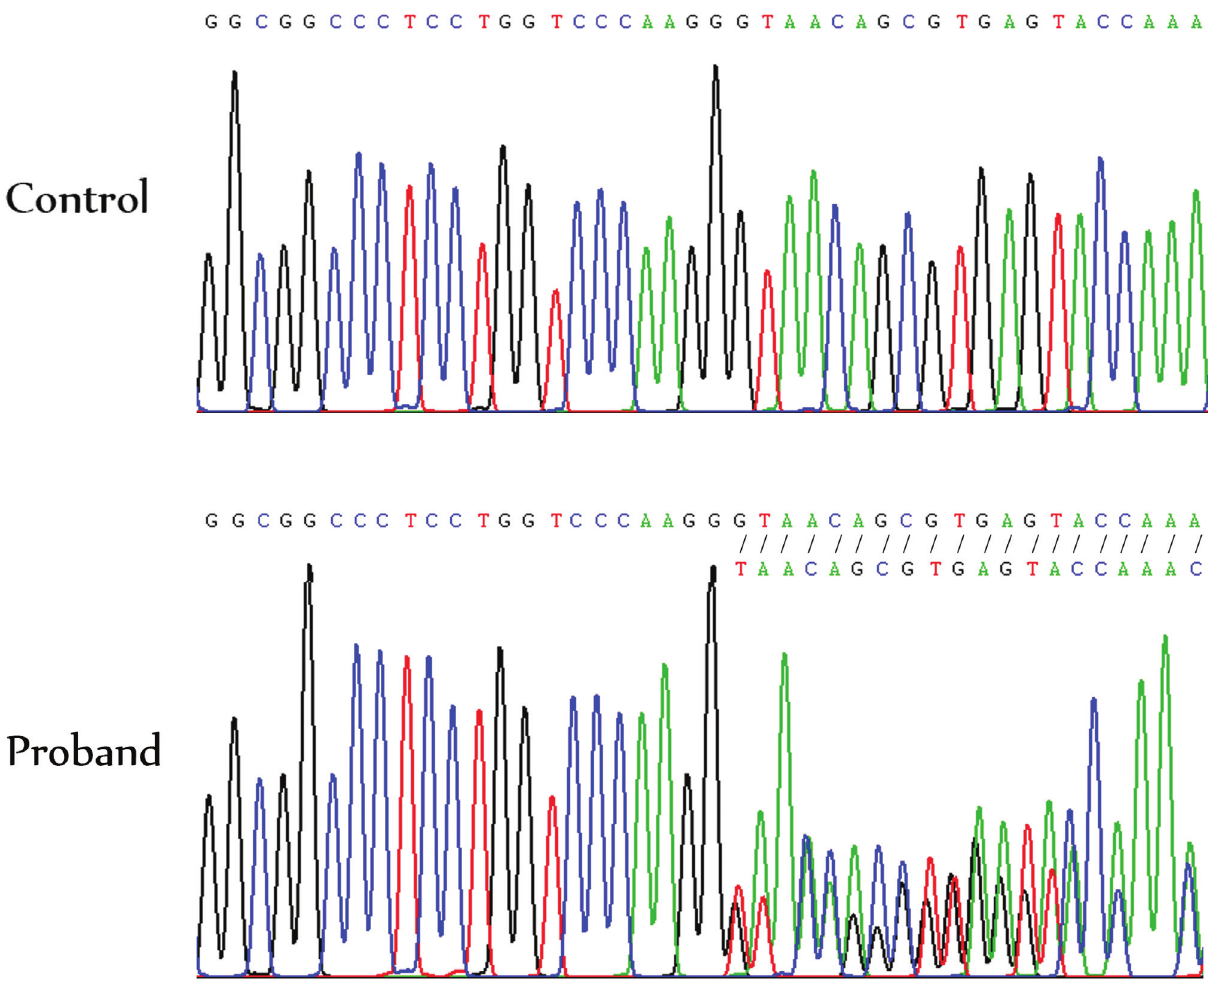
Figure 2 - Electropherogram showing the COL1A1 c.1290delG mutation in heterozygosis in the proband compared to a normal